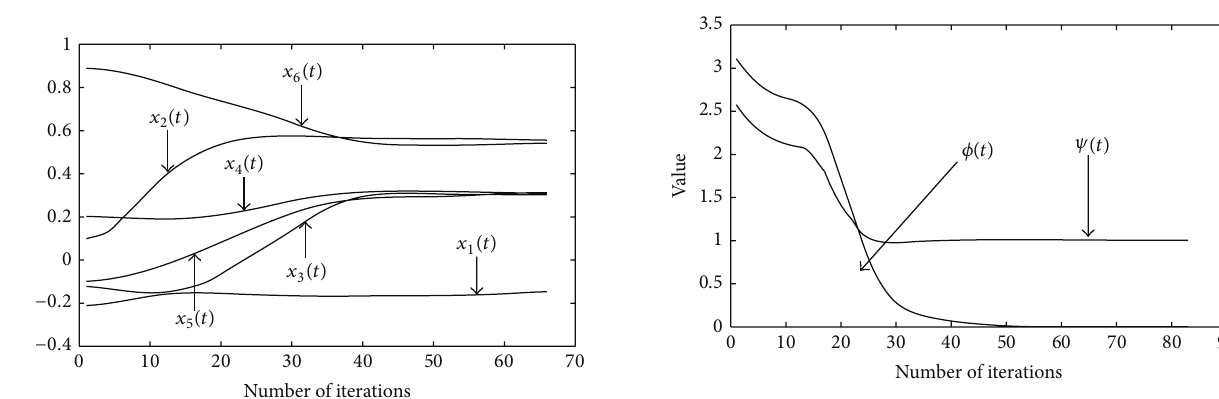
Figure 8: Trajectories of 𝑥(𝑡) , the solution of (33) with initial 𝑥(0) as (55), which should converge to the imaginary part of an eigenvector of 𝐴 corresponding to the eigenvalue 𝜆 5 .